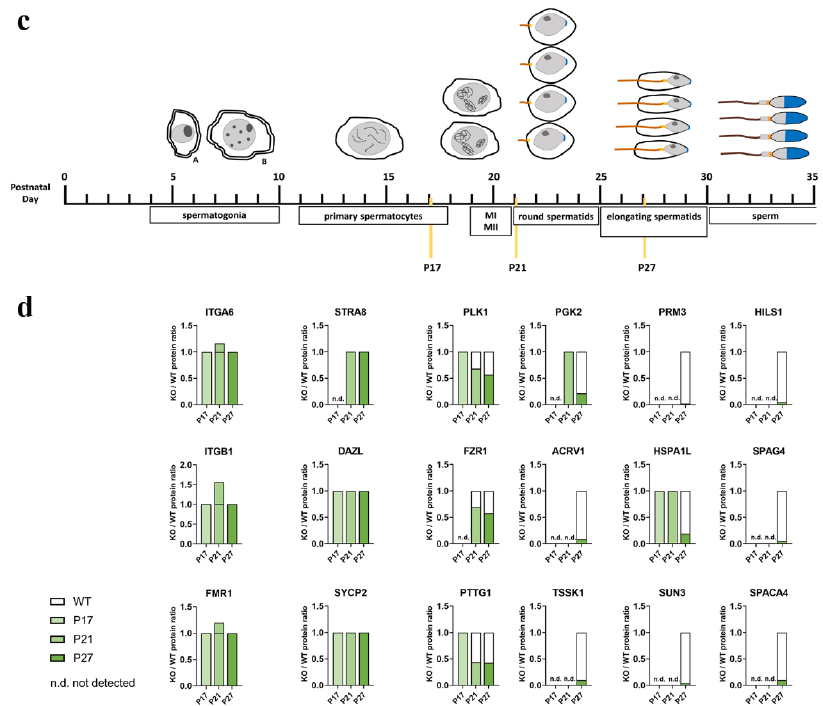
Figure 2. ( a ) Schematic design of breeding, dissection, and extraction of protein and RNA for molecular profiling at three age points. ( b ) Number of successful protein quantifications and of significant dysregulations with relevant effect size (log2 difference ≤− 0.5 or ≥ 0.5) is shown for each age point (shades of green reflect age progression). ( c ) Scheme according to [41,42] , illustrating what differentiation stages were studied within the almost synchronous spermatogenesis during the first 27 postnatal days of mice. ( d ) Mass spectrometry label-free quantification of specific proteins known as markers of successive maturation stages during spermatogenesis. Boxes are normalized to WT, the Y -axis value 1 representing 100%, and a partially green box suggests fewer numbers of cells reaching this stage. A moderate reduction was first observed at P21 for late spermatocyte markers PLK1, FZR1, and PTTG1. A massive reduction was observed at P21 for round spermatid markers PGK2, ACRV1, and TSSK1, while a total loss was observed at P27 for elongating spermatid markers PRM3, and SUN3, as well as for sperm markers HILS1, SPAG4, and SPACA4. n.d. = not detected.